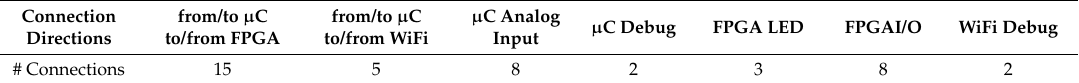
Table 1. Connections between microcontroller ( µ C), FPGA, and